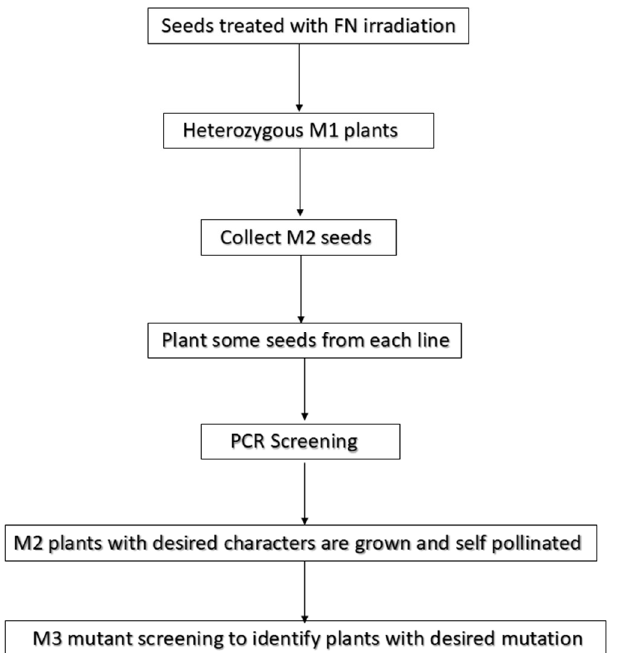
Figure 1. Generalized flow chart showing steps involved in the development and evaluation of mutant population derived from the plants treated with fast neutron. Table 2. Study of fast neutron mutagenesis in different organisms.